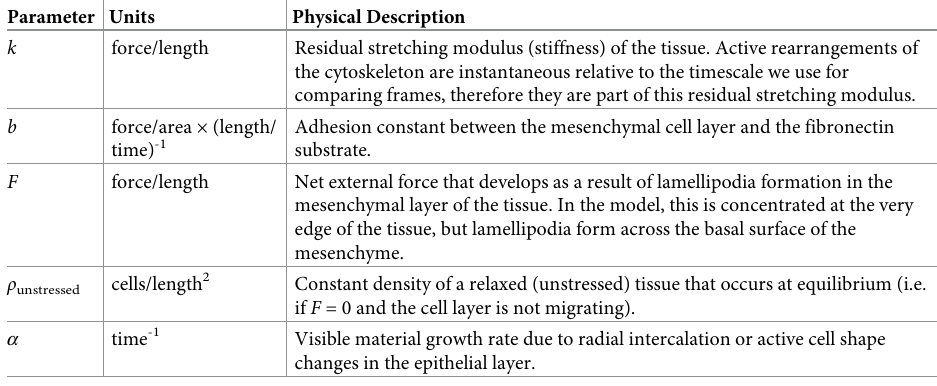
Table 1. Mathematical model parameters, units, and